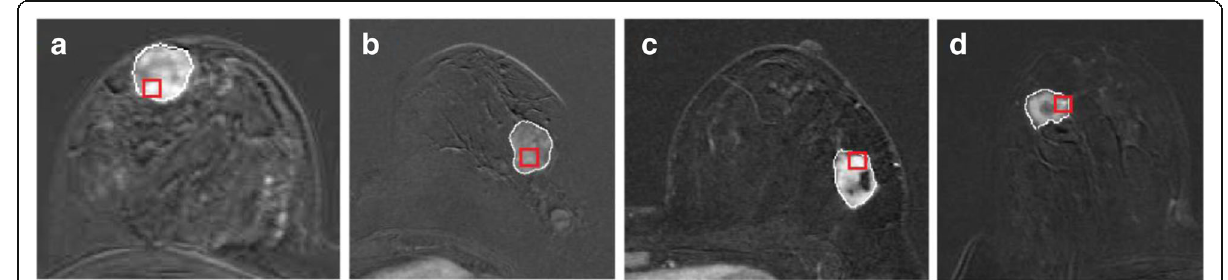
Fig. 11 Detected benign and malignant lesions by the proposed CAD system. a , b Benign lesions. c – d Malignant lesions on the subtracted images at the first post-contrast time point. The squared markers refer to the potential lesion voxels obtained by the presented method. These potential lesion voxels are the seed points for the region growing algorithm. The connected component boundaries of the legions are properly